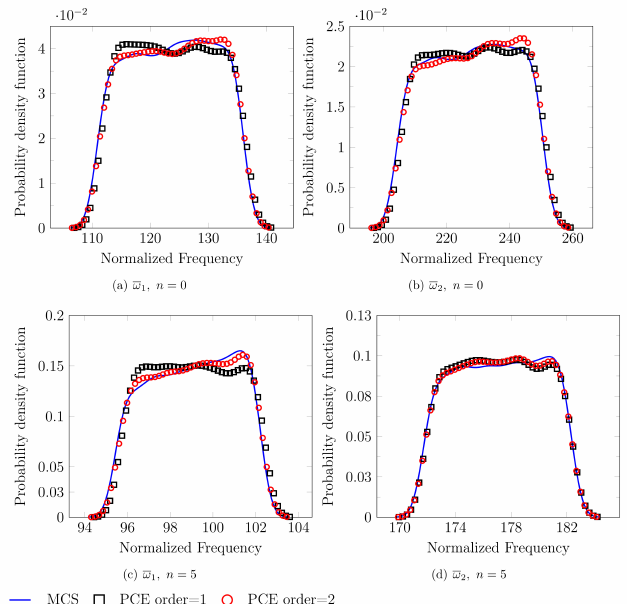
Figure 5. Case A: Variation of the probability density function as a function of normalized frequency, for the first two normalised frequencies; considering gradient index, n = 0, 5 and the Young’s modulus of the ceramic as